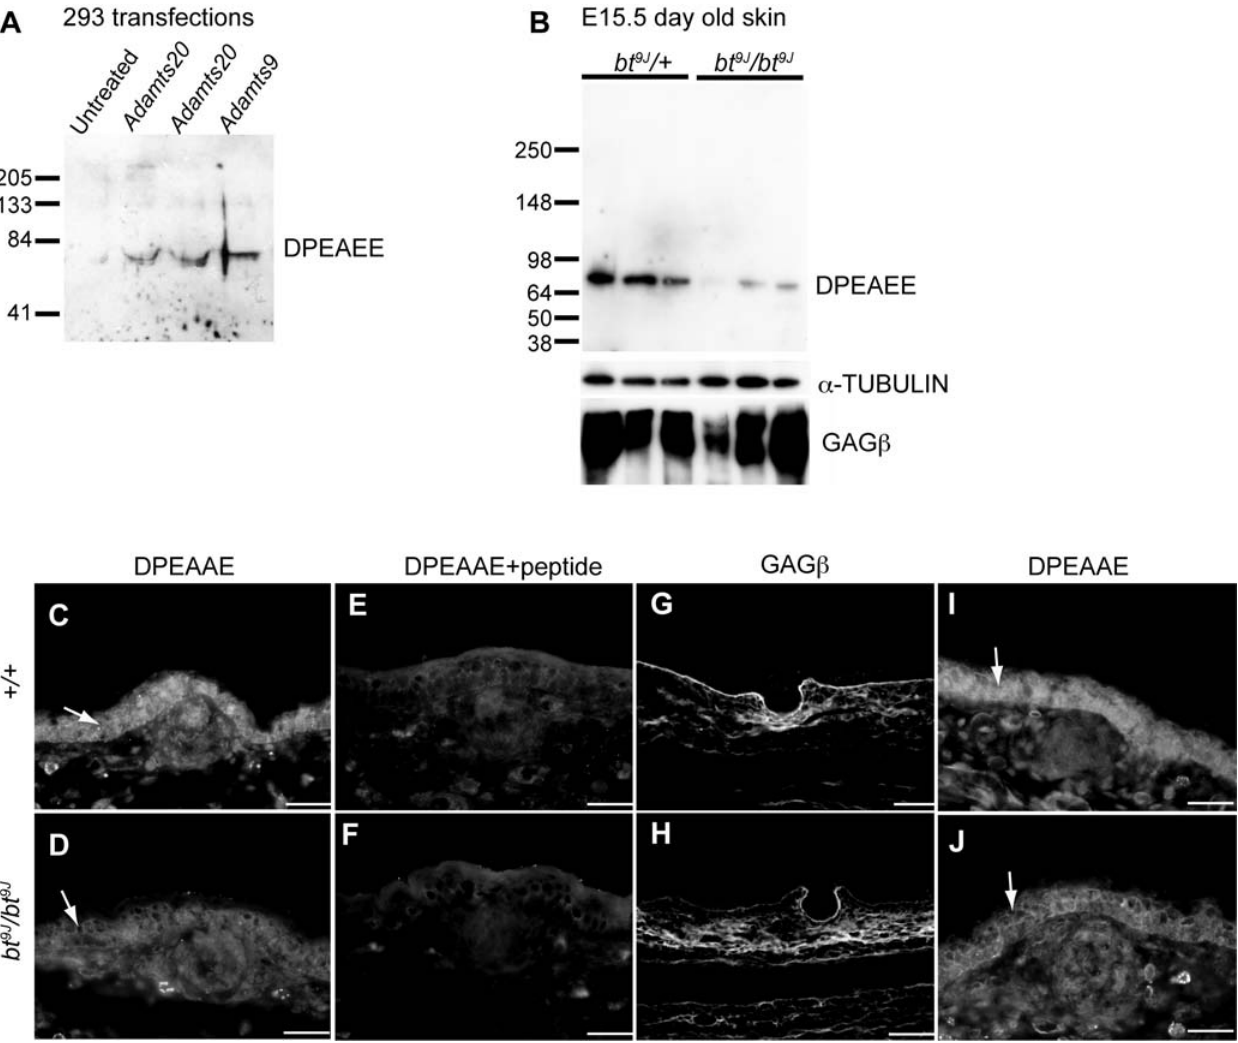
Figure 7. ADAMTS20 cleaves versican invitro and invivo . (A,B) Western analyses probed with anti-DPEAEE that recognizes the 70 KDa versican cleavage product. (A) Protein extracts from 293 cells transfected with vector alone, Adamts20 (2 experiments) and Adamts9, and incubated with versican. (B) Protein extracts of E15.5 day old skin from six different bt 9J / + and bt 9J /bt 9J embryos. Anti- a -Tubulin serves as a loading control and anti- GAG b indicates levels of total versican. (C–J) Immunofluorescence images of + / + (C,E,G, I) or bt 9J /bt 9J (D,F,H,J) E15.5 10 m m trunk (C–H) and forelimb (I,J) sections stained with anti-DPEAAE (C,D,I,J), anti-DPEAAE and DPEAEE peptide (E,F), and anti-GAG b (G,H). The anti-DPEAEE staining in the proliferating layer of the epidermis (indicated by arrows) is reduced dramatically in trunk sections and reduced to a lesser extent in forelimb sections from bt 9J /bt 9J embryos. The scale bars are: (C–F,I,J) 50 m M, (G,H) 100 m M.